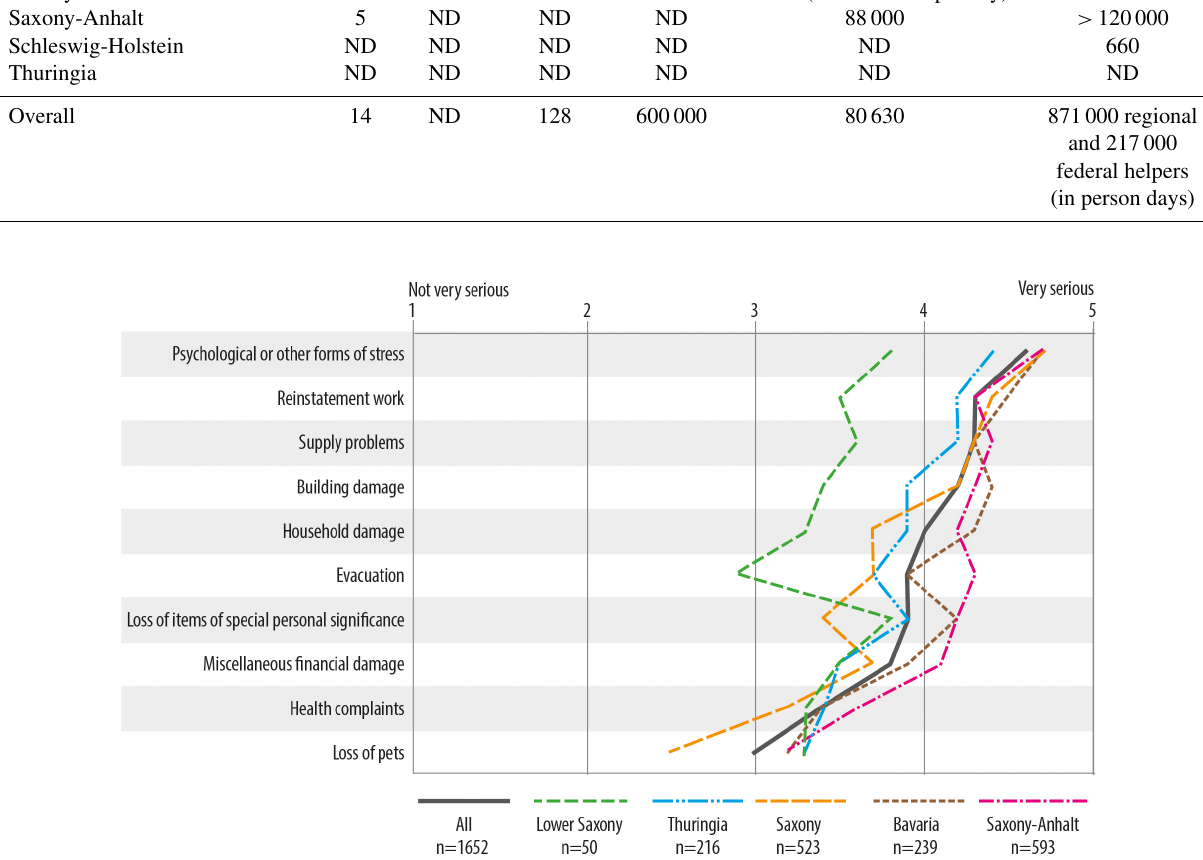
Figure 3. Average perception of the severity of flood impacts witnessed by flood-affected residents and assessed on a scale of 1 (impact was not very serious) to 6 (impact was very